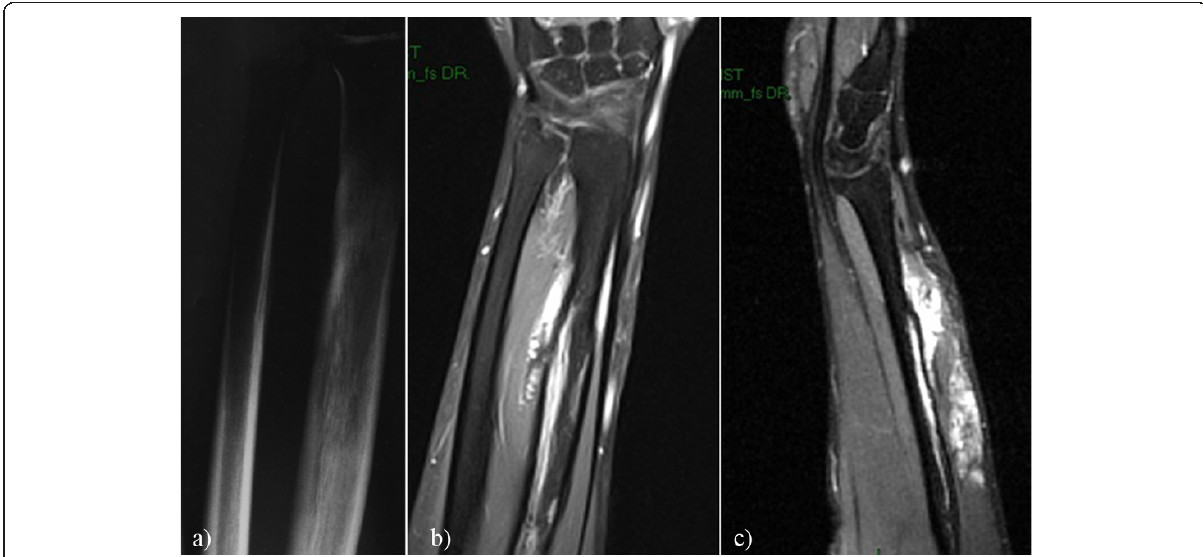
Figure 1 X-ray and MRI forearm examination . 1.a . AP radiograph of the distal forearm . Lamellar periostosis of the radius bone associated with diffuse bone structure change and an area of reduced bone density (a) are seen. 1.b, c . MRI forearm examination . Sagital FS T1 shows inhomogeneous tumor with irregular contours with diffuse post contrast enhancement and osseous invasion (b). MRI coronal section T1TSEfs shows post contrast better highlighting of the osseous invasion (c).